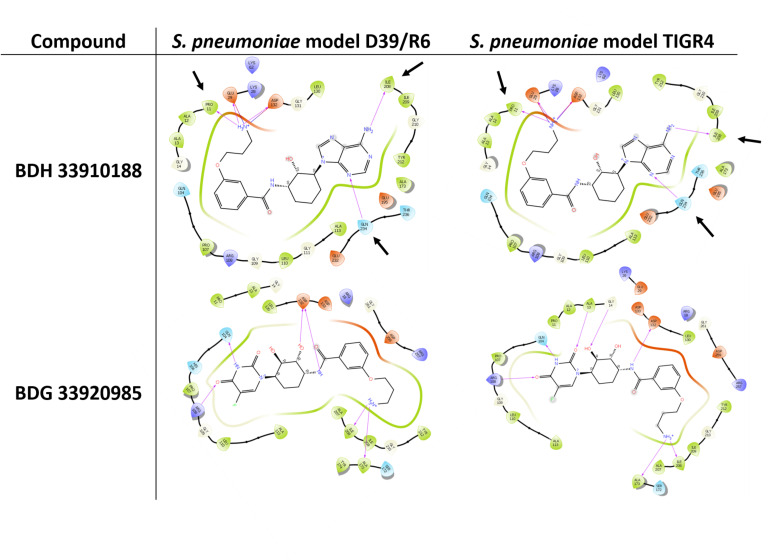
Illustration of protein-ligand interaction. Compounds BDH 33910188 and BDG 33920985 with UDPG:PP of streptococcal strains D39/R6 and TIGR4. Arrows point toward the residues which could be responsible for the improvement in the docking score (DS) in the model. For compound BDH 33920985, DS of S. pneumoniae models were lower than those of the L. monocytogenes models.